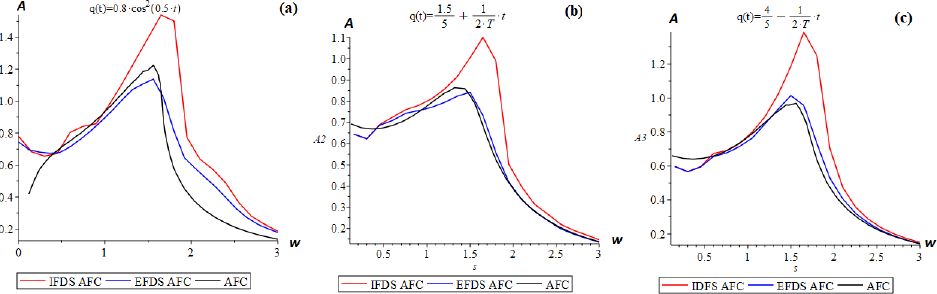
Figure 16. Numerical and analytical AFC of the fractional Duffing oscillator for various types of function q ( t ) .